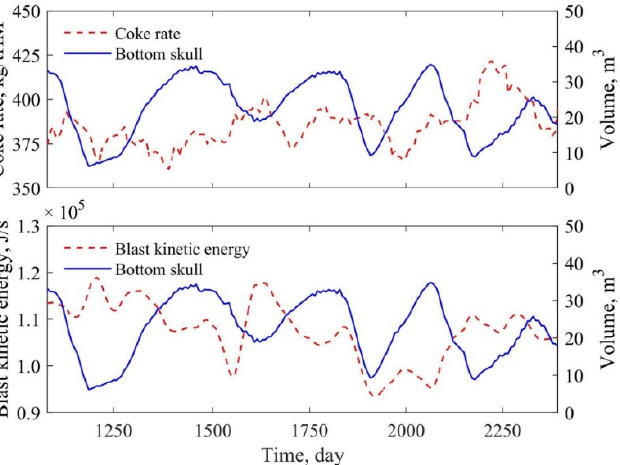
Figure 7. Evolutions of the normalized volumes of bottom skull (solid line) and sidewall (dashed line) skull.